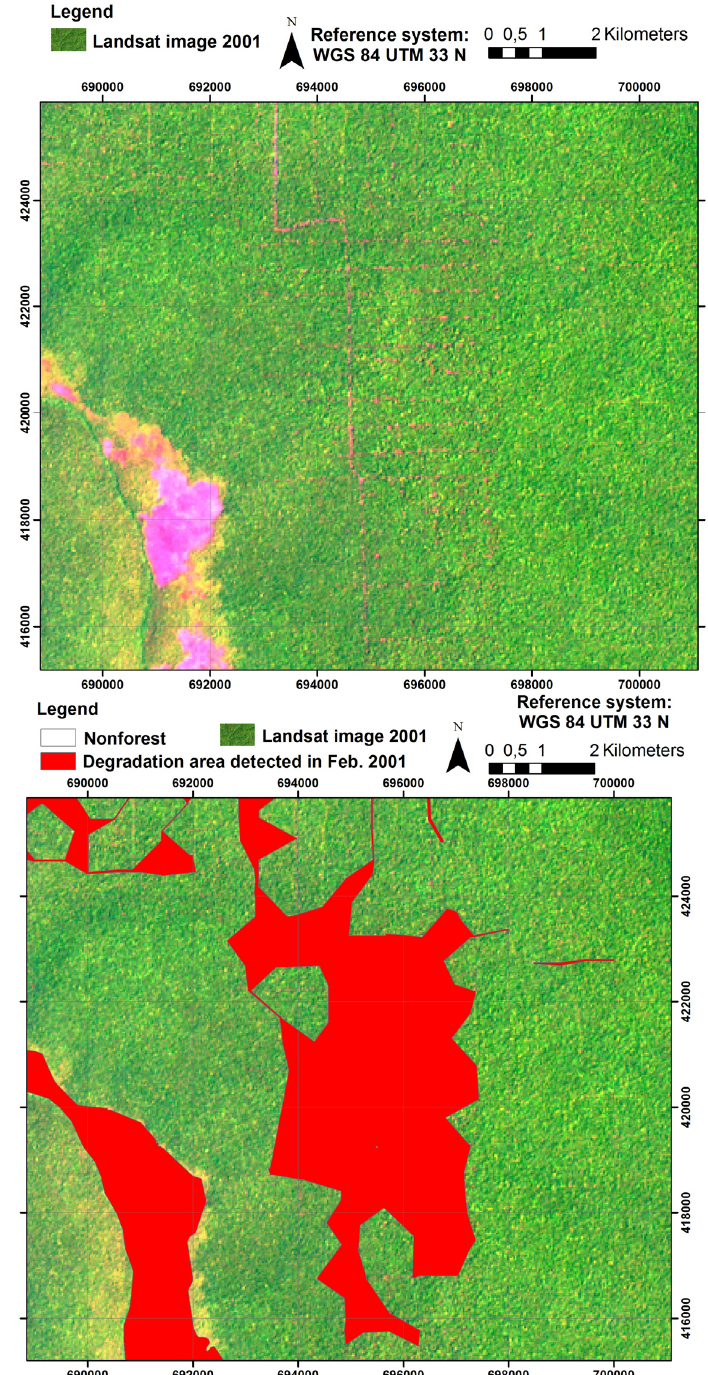
Figure 7. Detail of CAR result: ( left ) Landsat image 2001, ( right) Landsat image 2001 superimposed with nonforest areas (white) and forest areas affected by degradation